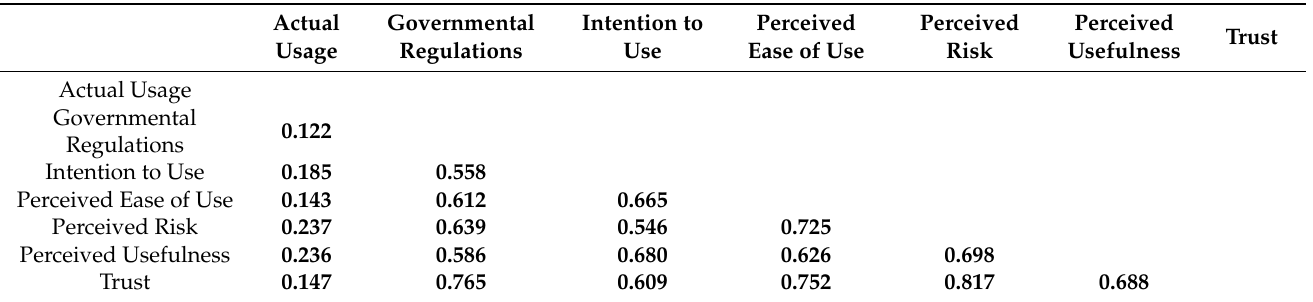
Table 4. Discriminant Validity: Heterotrait-Monotrait Ratio Of Correlations